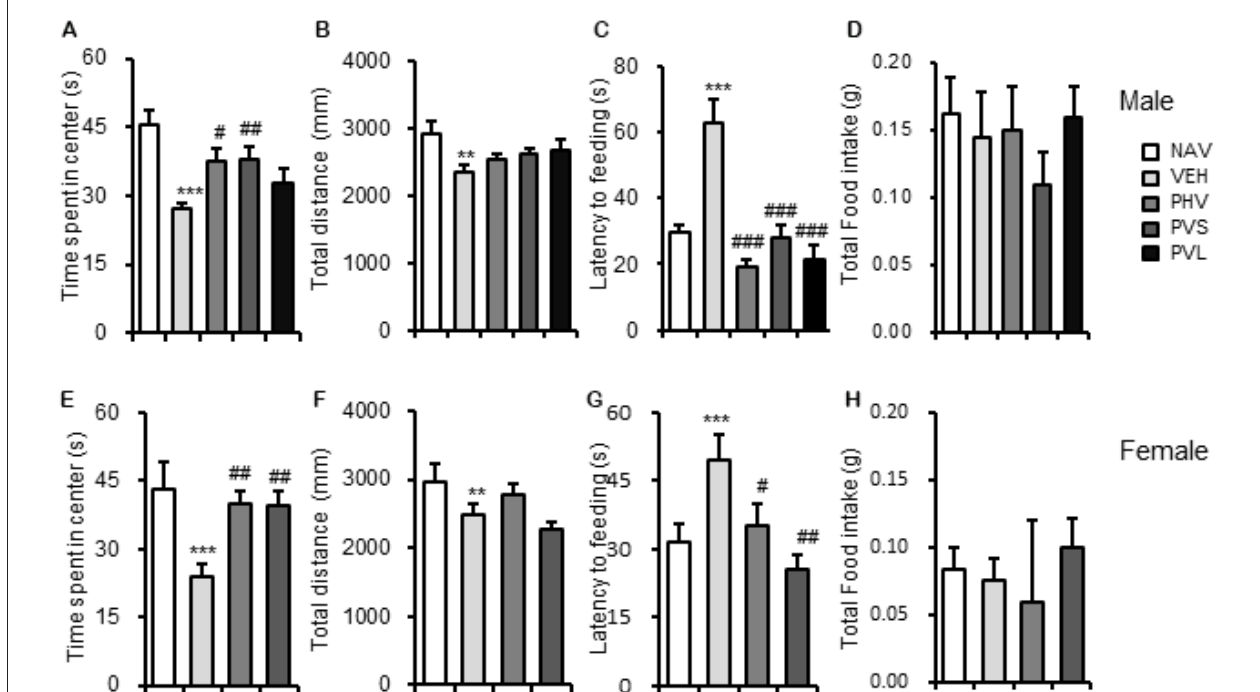
FIGURE 2 | HRW administration reversed the anxiety-like behaviors in maternal VPA-exposed mice offspring. Anxiety-like behaviors were assessed by the OFT and NSF test. HRW administration significantly reversed the decreased time spent in the center of both male (A) and female (E) mice offspring, while had no significant effect on the total distance (B,F) in the OFT. HRW administration significantly reversed the increased latency to feeding of both male (C) and female (G) mice offspring, while had no significant effect on the total food intake (D,H) in the NSF test. OFT, open field test; NSF, novelty suppressed feeding test. Data are expressed as the mean ± SEM. ∗∗ P < 0.01, ∗∗∗ P < 0.005 compared with the saline-injected group (NAV); # P < 0.05, ## P < 0.01, ### P < 0.005 compared with the VPA-exposed group (VEH; n = 6–10 per